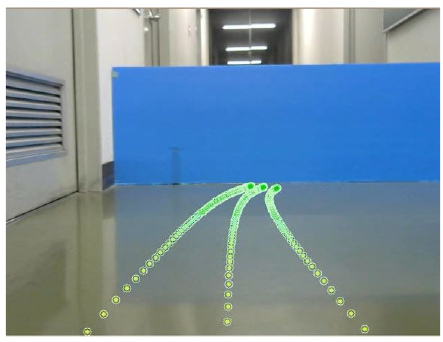
Figure 9. Example of visual